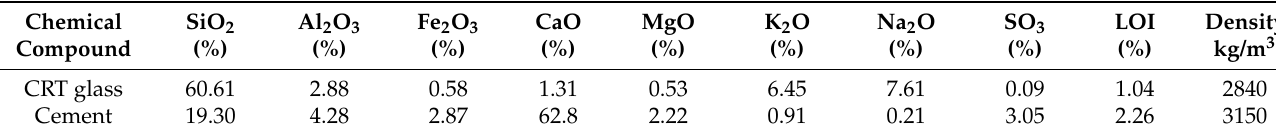
Table 2. Chemical composition of CRT glass and